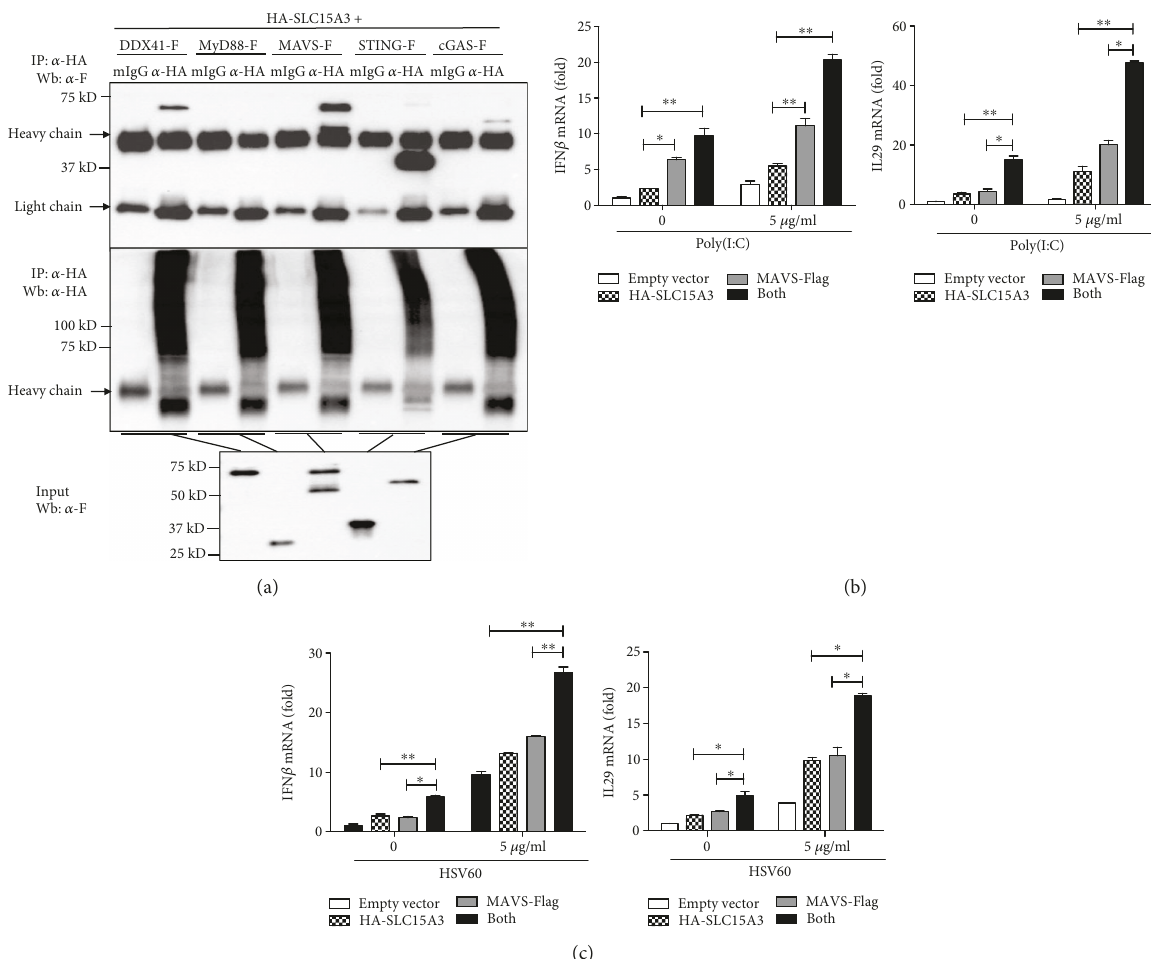
Figure 5: SLC15A3 interacts with MAVS and STING and augments MAVS- and STING-mediated IFN induction. (a) 293T cells were transfected with the indicated plasmids before coimmunoprecipitation and immunoblot analyses were performed with the indicated antibodies. (b) qRT-PCR analysis of IFN β in 293T transfected with indicated plasmids for 16h and then transfected with poly(I:C) for 8h. (c) qRT-PCR analysis of IFN β in 293T transfected with indicated plasmids for 16h and then transfected with HSV60 for 8h. ∗ P < 0 05 , ∗∗ P < 0 01 (unpaired t -test). Data (mean ± sd) are representative of three experiments with similar